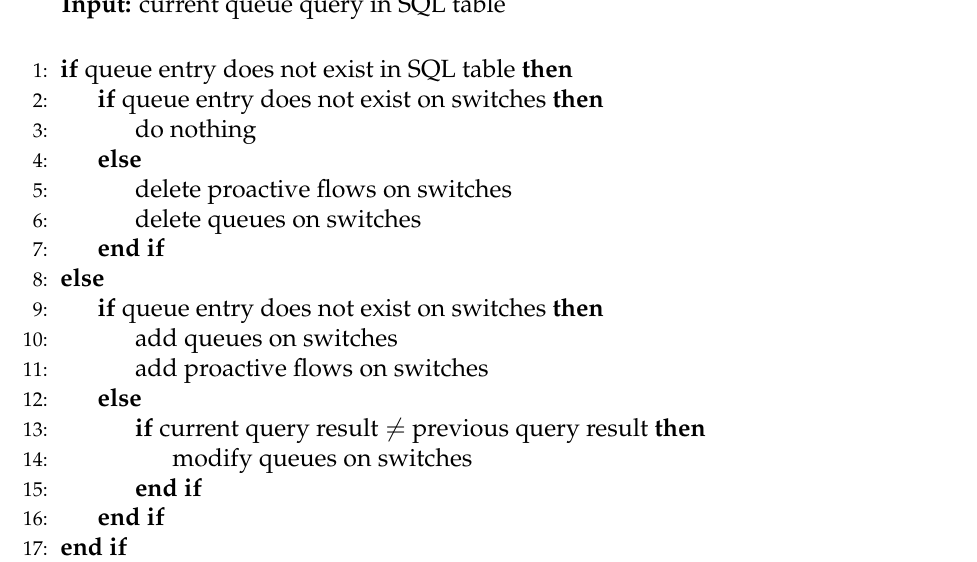
Algorithm 1 Dynamic QoS